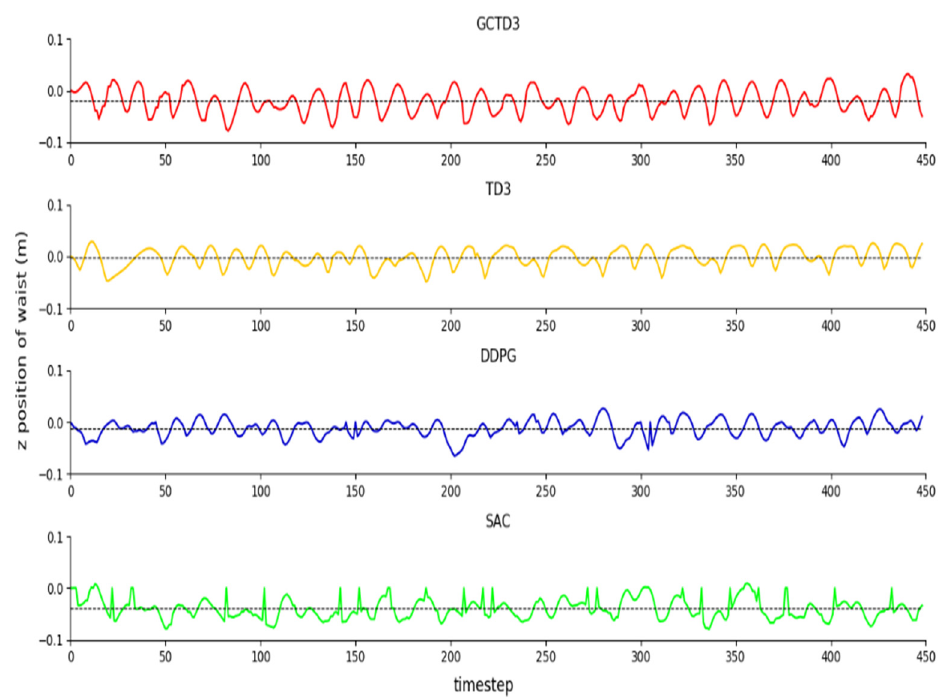
Figure 10. Graph of the position of robot’s body oscillation during walking when using reinforcement learning algorithms GCTD3, TD3, DDPG, and SAC.